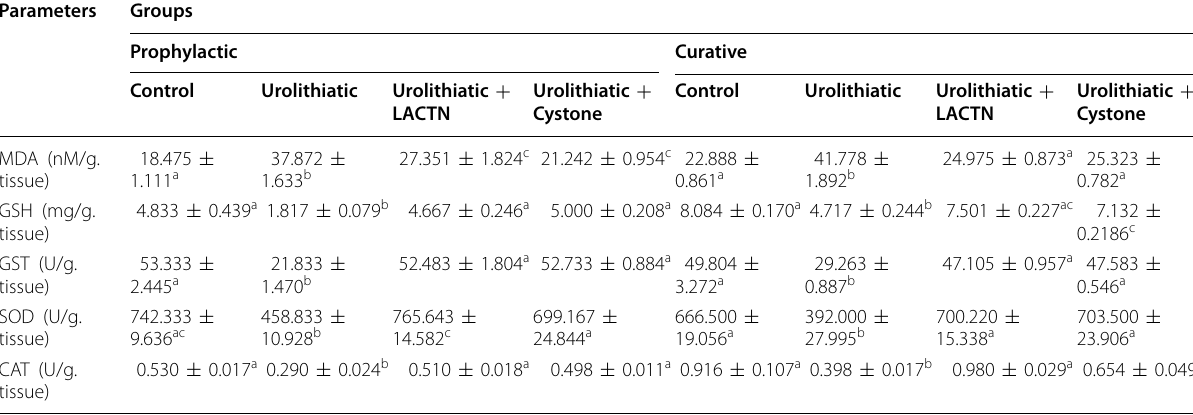
Values are expressed as mean SEM ( n 6). ANOVA post hoc with Duncan’s test was performed to compare between groups. Values with different row superscript ± = letters of the same regimen are significantly different ( P <